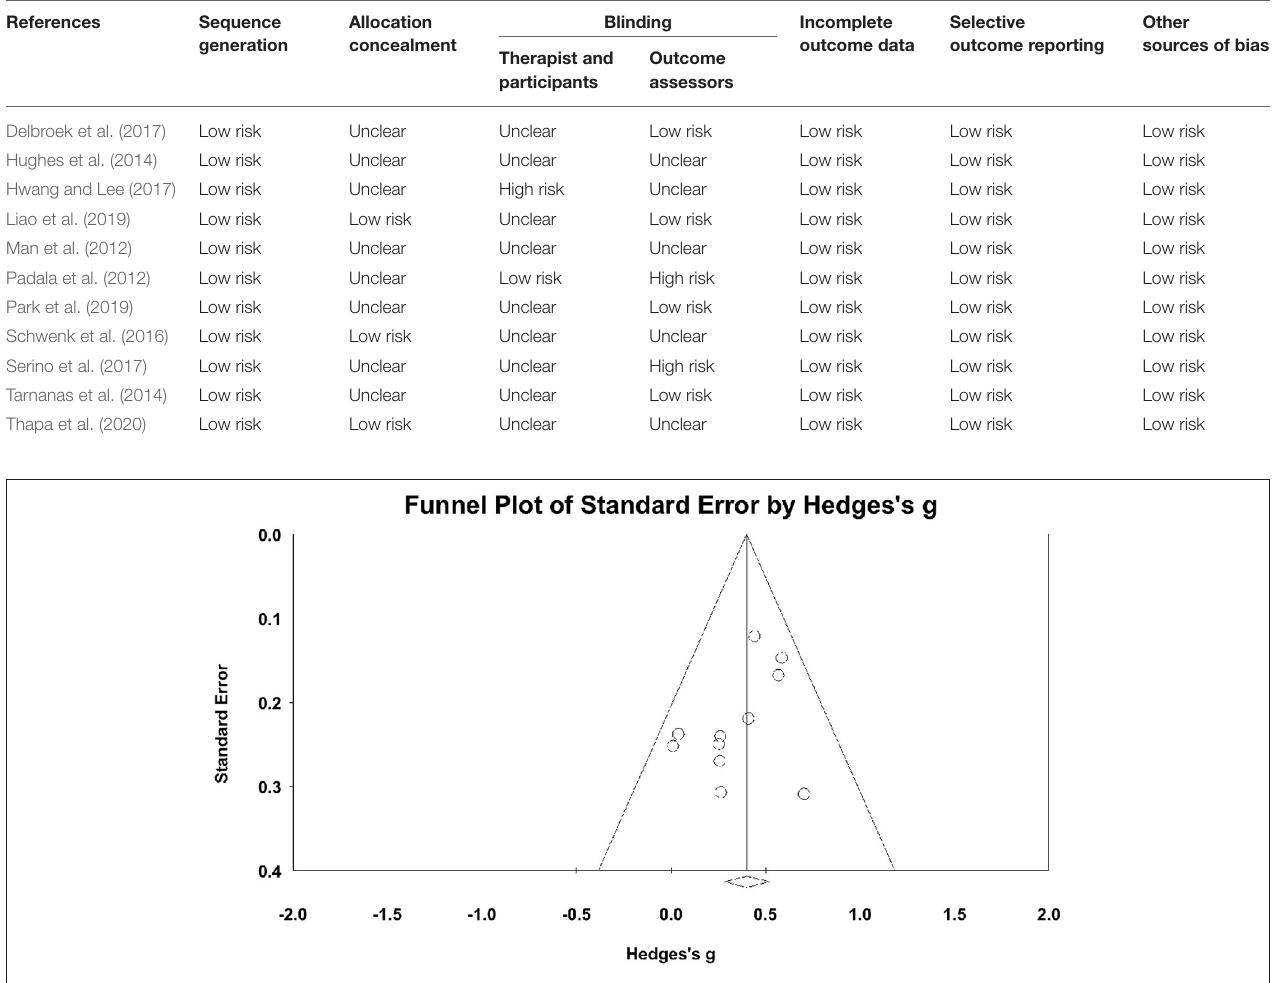
FIGURE 5 | Funnel plot for overall cognition with Hedge’s g on the X-axis and the standard error on the